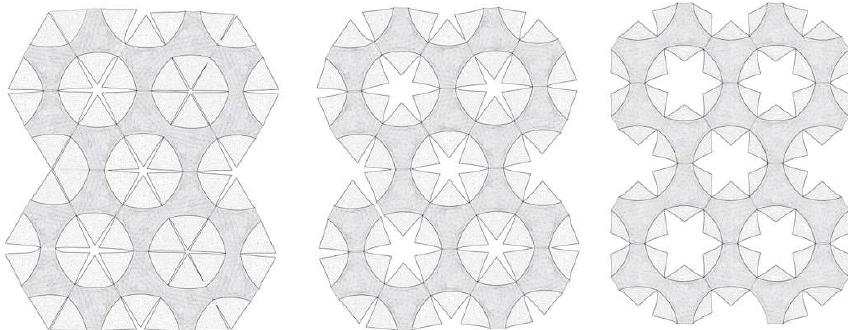
Figure 11. The curved-line folding mechanism can be applied to various patterns and tessellations.